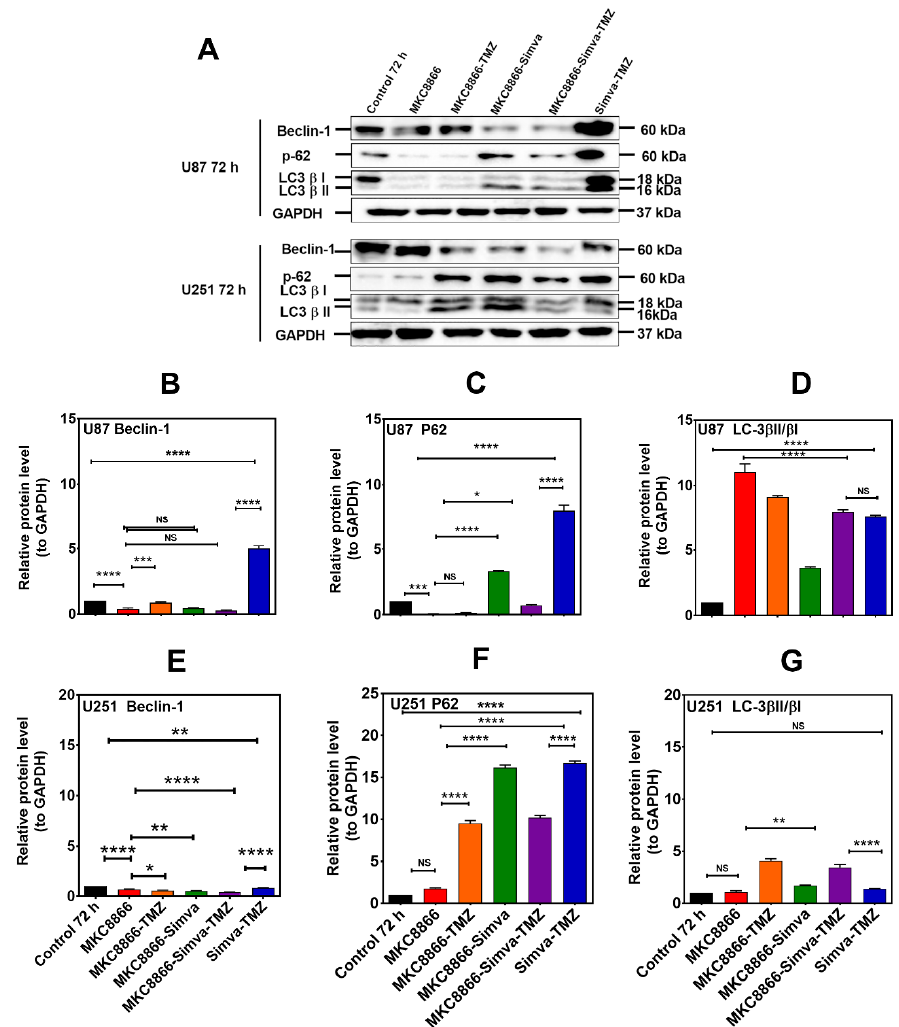
Figure 4. Simva–TMZ modulates the autophagy machinery via the IRE-1 pathway. ( A ) After pretreatment with MKC8866 (30 µM, 4 h), U87 and U251 cells were co-treated with TMZ, Simva, or Simva–TMZ for 72 h. The protein levels of Beclin-1, p62, LC3 β -II, and LC β -I were determined by immunoblotting. Simva–TMZ induced an inhibition of autophagy flux (accumulation of p62 and LC3 β -II) in GBM cells. In Simva–TMZ-treated cells, MKC8866 increased p62 and Beclin-1 degradation, while it di ff erentially a ff ected the LC3 β -II / LC3 β -I ratio; GAPDH was used as loading control. Densitometric analysis of the Western blot bands confirmed that Simva–TMZ significantly induced Beclin-1 and p62 accumulation in both U87 and U251 cells ( p < 0.0001), which was markedly prevented in the presence of MKC8866 ( B , C , E , F ). In addition, MKC8866 increased the LC3 β -II / LC3 β -I ratio in Simva–TMZ-treated U251 cells ( p < 0.0001) ( G ), whereas it did not change LC3 β -II / LC3 β -I in U87 cells ( p < 0.0001) ( D ). The data are shown as the mean ± SD from three independent experiments (* p < 0.05; ** p < 0.01, *** p < 0.001; **** p <